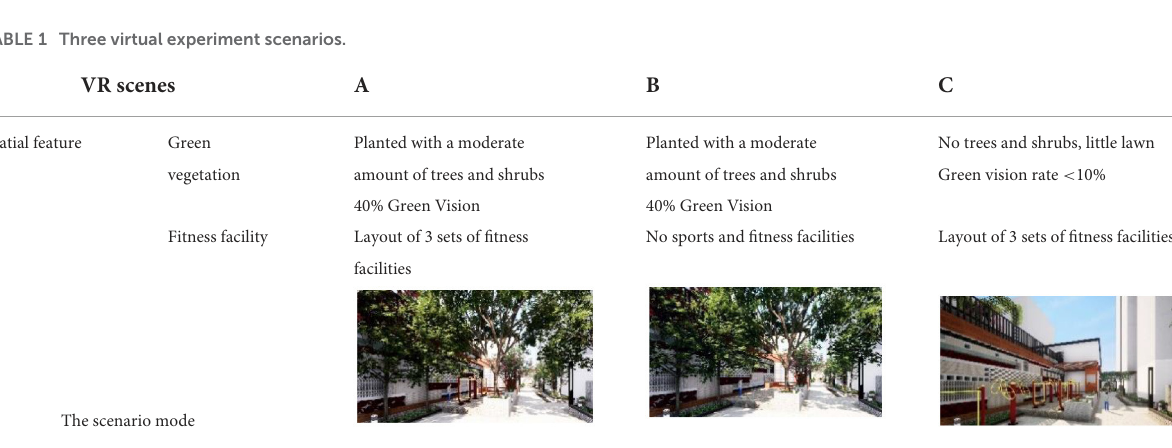
TABLE 1 Three virtual experiment